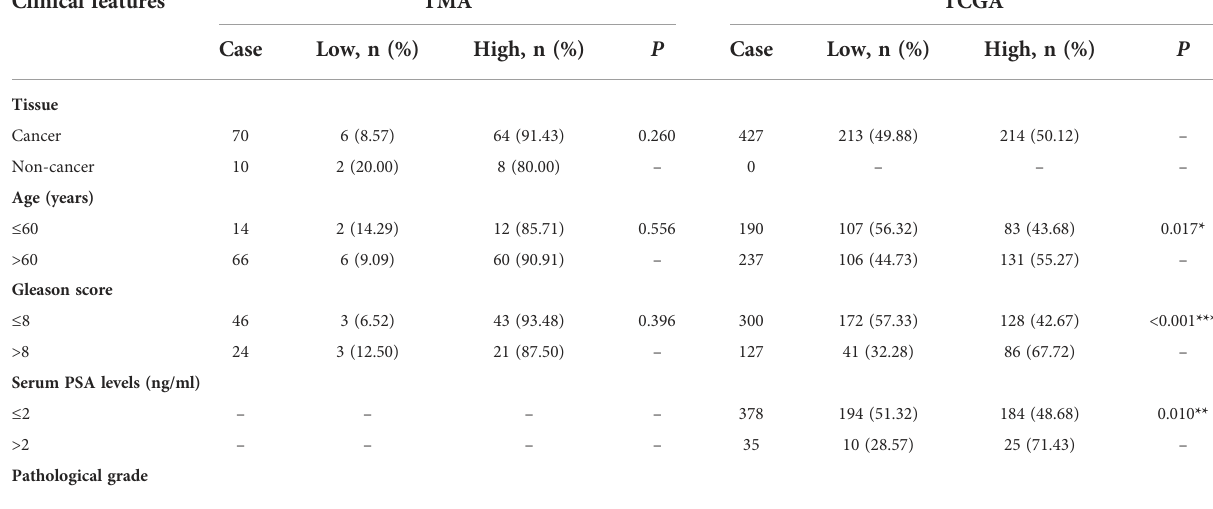
TABLE 3 Correlation of HAVCR2 expression with clinicopathological features in PCa